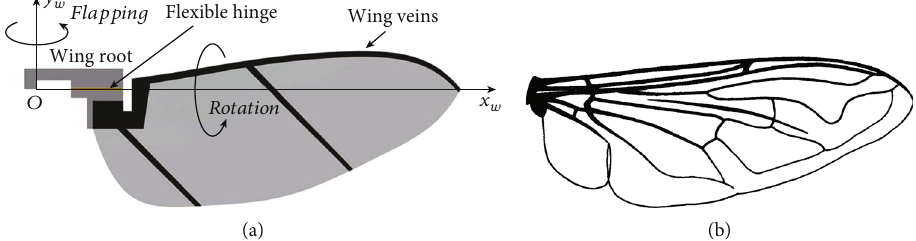
Figure 2: Shape of (a) the arti fi cial wing and (b) the Eristalis tenax wing from [25].